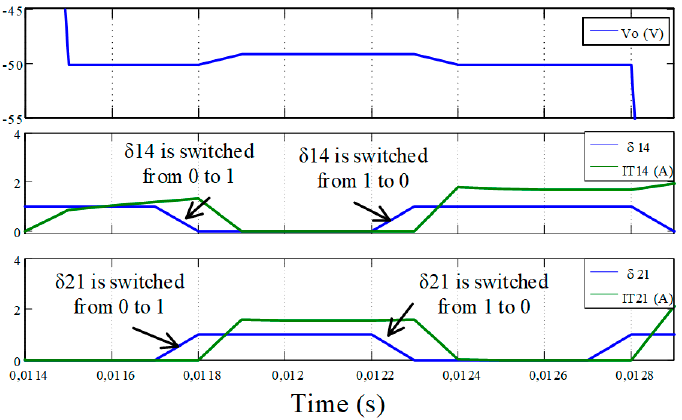
Figure 8. Output voltage V o (t), currents IT21 and IT14, and command of the switches T21 and T14 (Zoom 3).